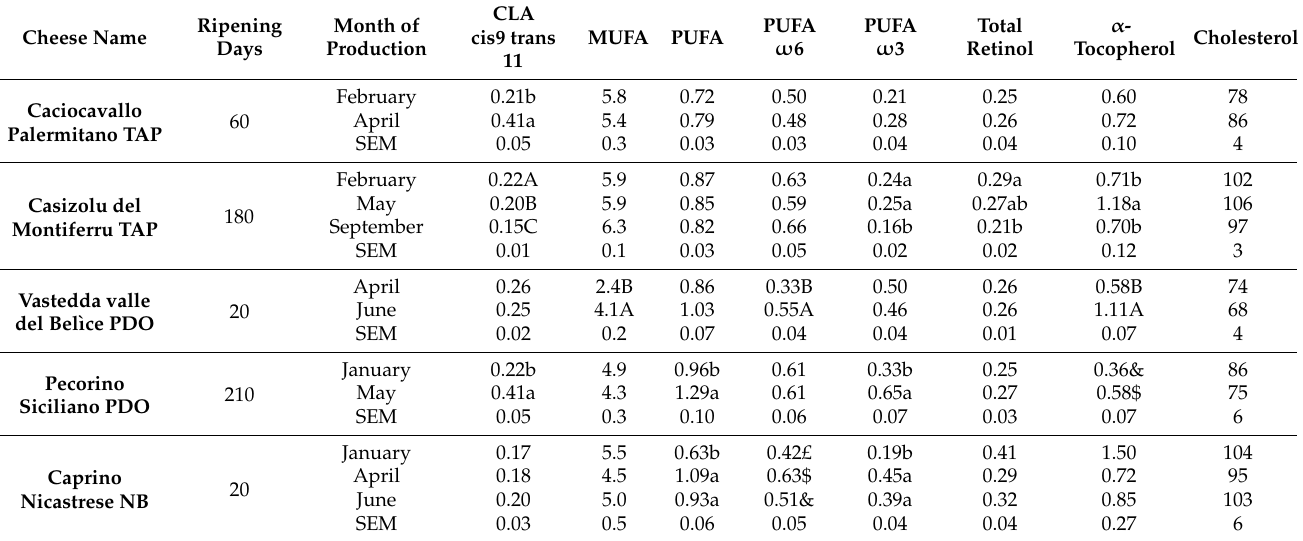
Table 3. Effect of the month of production on the fatty acids (g/100 g of cheese), the liposoluble vitamins, and the cholesterol (mg/100 g of cheese) of the AGER selection